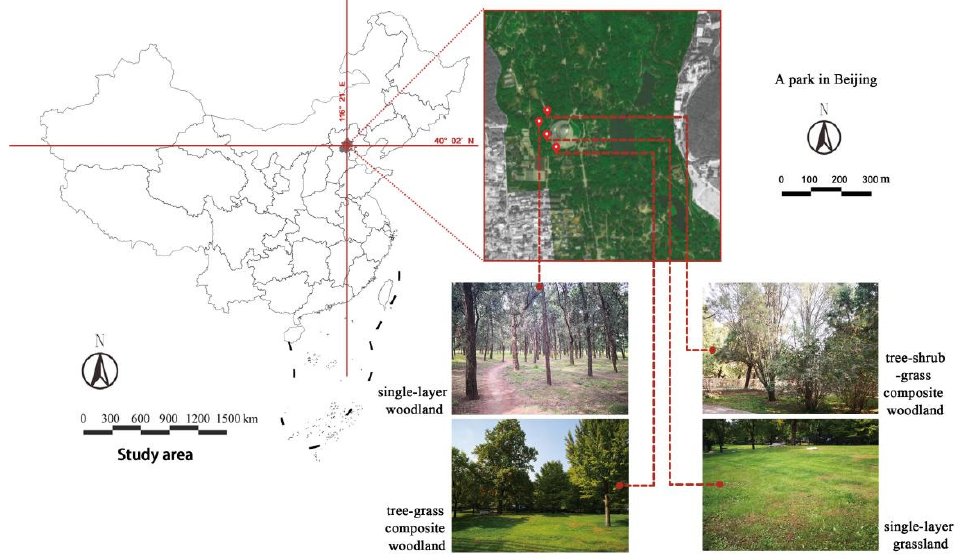
Figure 1. Study area.